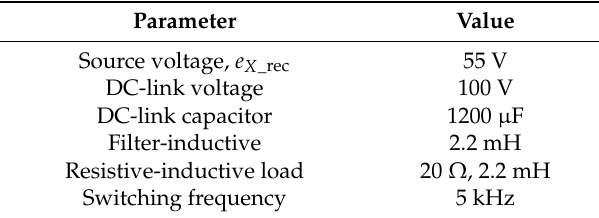
Table 6. Parameter settings for simulation and experiment.